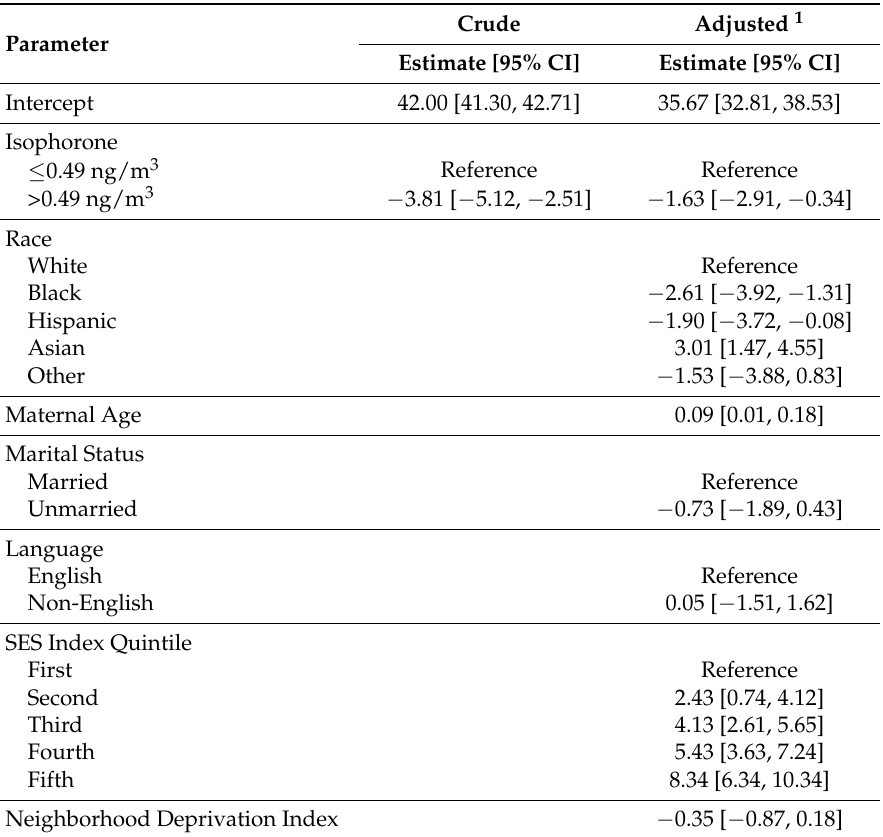
(Table 4), both high isophorone exposure [ − 1.48, 95% CI: − 2.79, − 0.1] and lower HOME